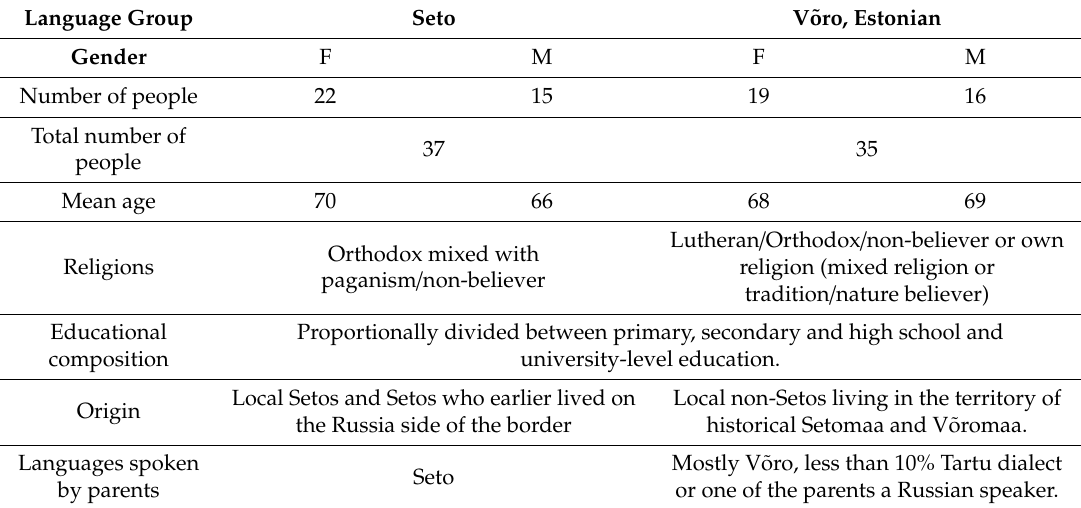
Table 1. Demographic information about the